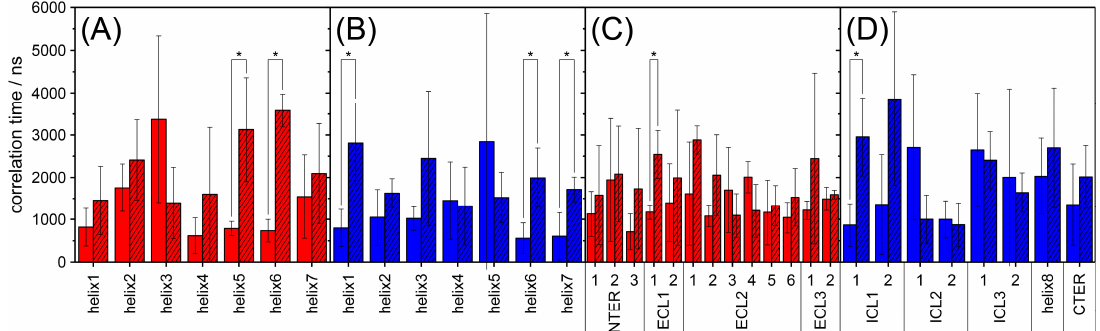
Figure 8. The correlation times of the individual segments that were obtained by fitting the ACFs extracted from the MD simulations. Open bars correspond to the apo state, whereas striped bars correspond to the antagonist-bound state. Panel ( A ) corresponds to the extracellular helix segments, whereas ( B ) shows their intracellular counterparts. Panels ( C , D ) show the loops, termini, and Helix 8, also grouped into extracellular and intracellular segments, respectively. In all panels, the arithmetic mean over all three runs is shown and the error bars correspond to the standard deviation. Statistically significant ( p < 0.05) higher values of the antagonist-bound state are indicated by